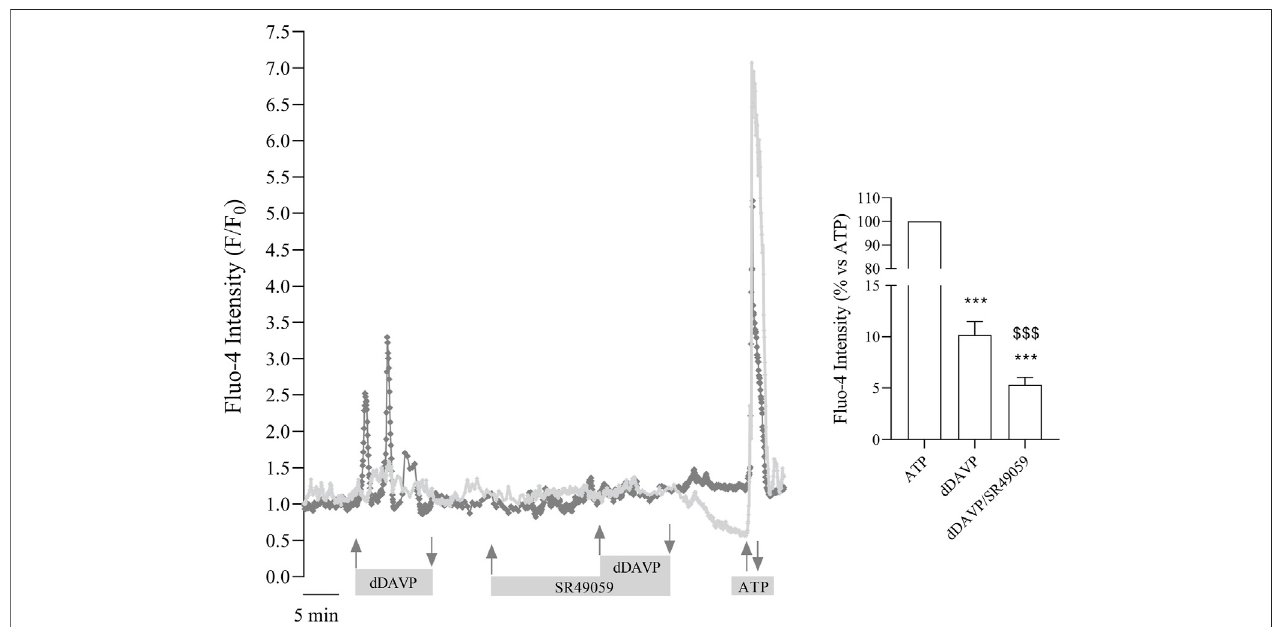
FIGURE 2 | Functional characterization of endogenous V1aR receptors in HCT8 cells. Cells were stimulated with 1 µM dDAVP or with 1 µM dDAVP and 100 nM SR49059, a V1aR antagonist. ATP (100 µM) stimulation was used as a positive control. dDAVP signi fi cantly increased cytosolic calcium. Stimulation with dDAVP in the presence of 100 nM SR49059 prevented the effect of dDAVP raising cytosolic calcium. Data are expressed as means ± S.E.M. and analyzed by one-way ANOVA followed by Tukey ’ s multiple Comparisons test (*** p < 0.001 vs. ATP; $$$ p < 0.001 vs. dDAVP).